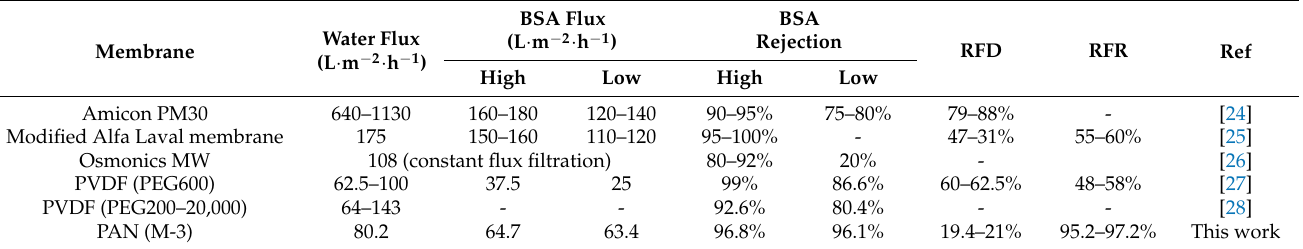
Table 3. The filtration performance of some commercial and laboratory-made membranes for BSA protein separation.